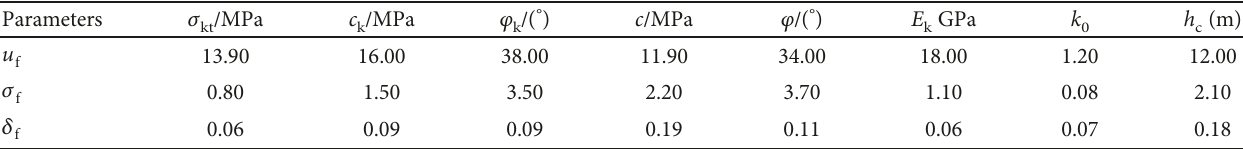
Table 3: Statistics of random variables in Yangliu mine.